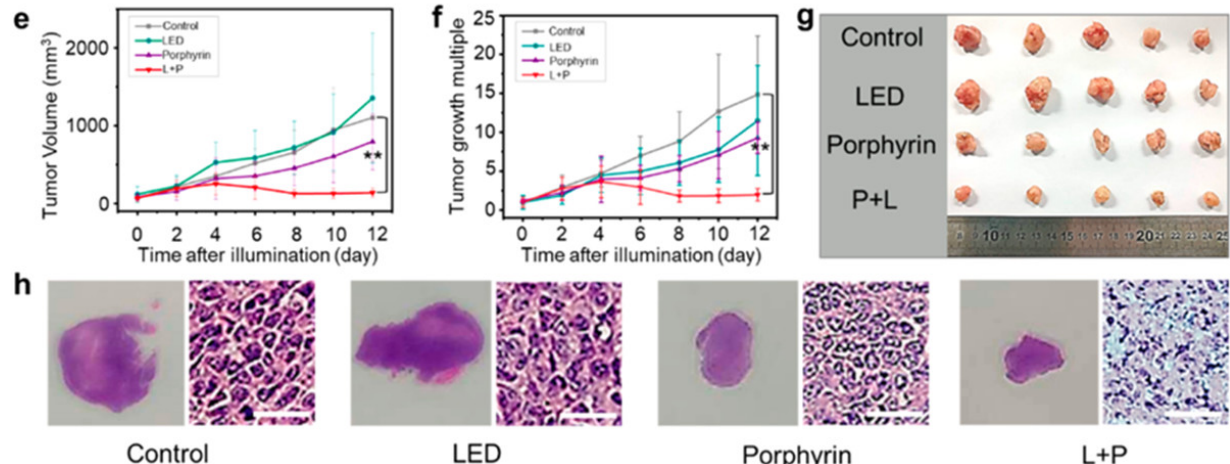
Figure 28. Experimental results of intermittent continuous light stimulation applied to a tumor in vivo [113]. ( a ) Electrical diagram of LED array. ( b ) Different views and states of the LED array